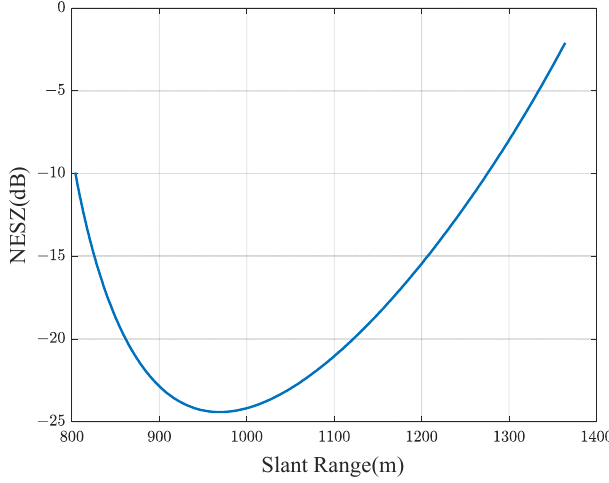
Figure 2. Simulation results of NESZ.